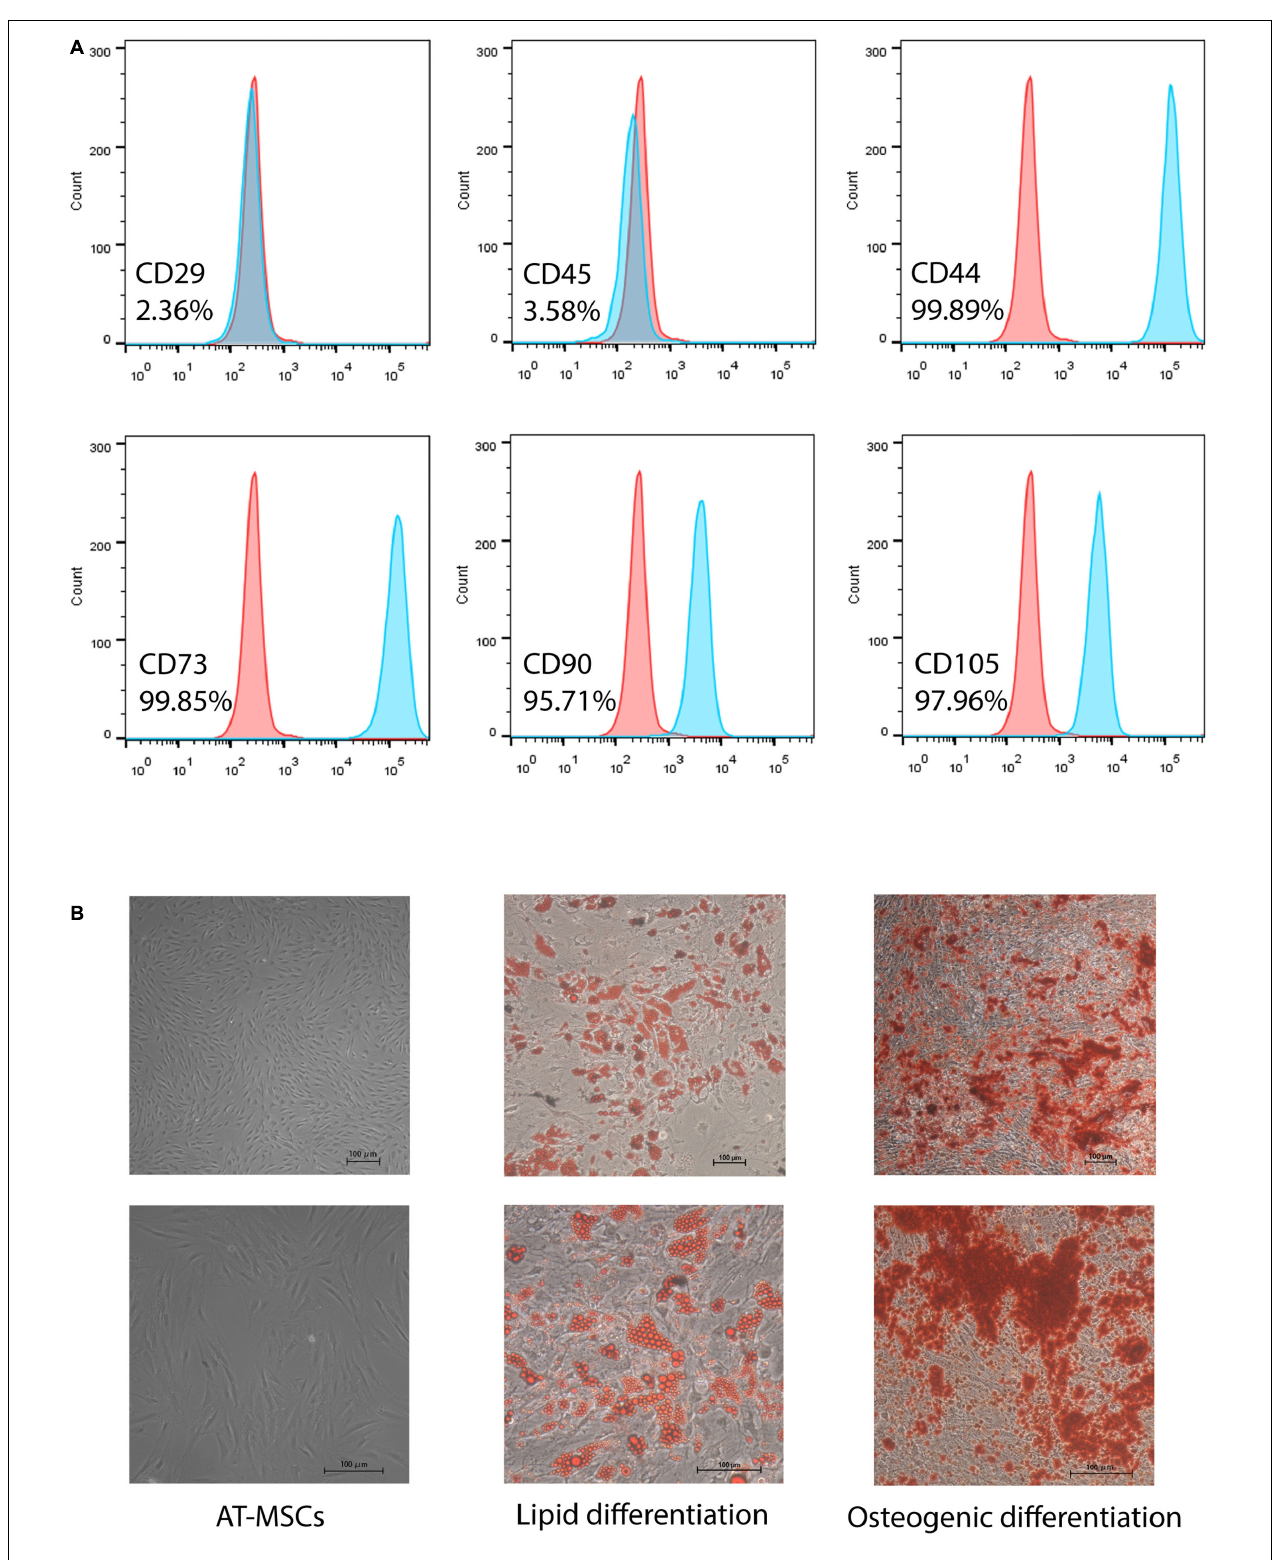
FIGURE 1 | Characterization of human adipose-tissue derived mesenchymal stem cells (AT-MSCs). (A) Representative of flow cytometry results of MSC markers: CD44, CD45, CD73, CD90, and CD105. (B) Morphology of AT-MSCs (left). Representative images of AT-MSCs differentiated into adipocytes and osteocytes (middle and right). Adipocytes and osteocytes were stained by Oil Red O and Alizarin red, respectively. Scale bar 100 µ m.